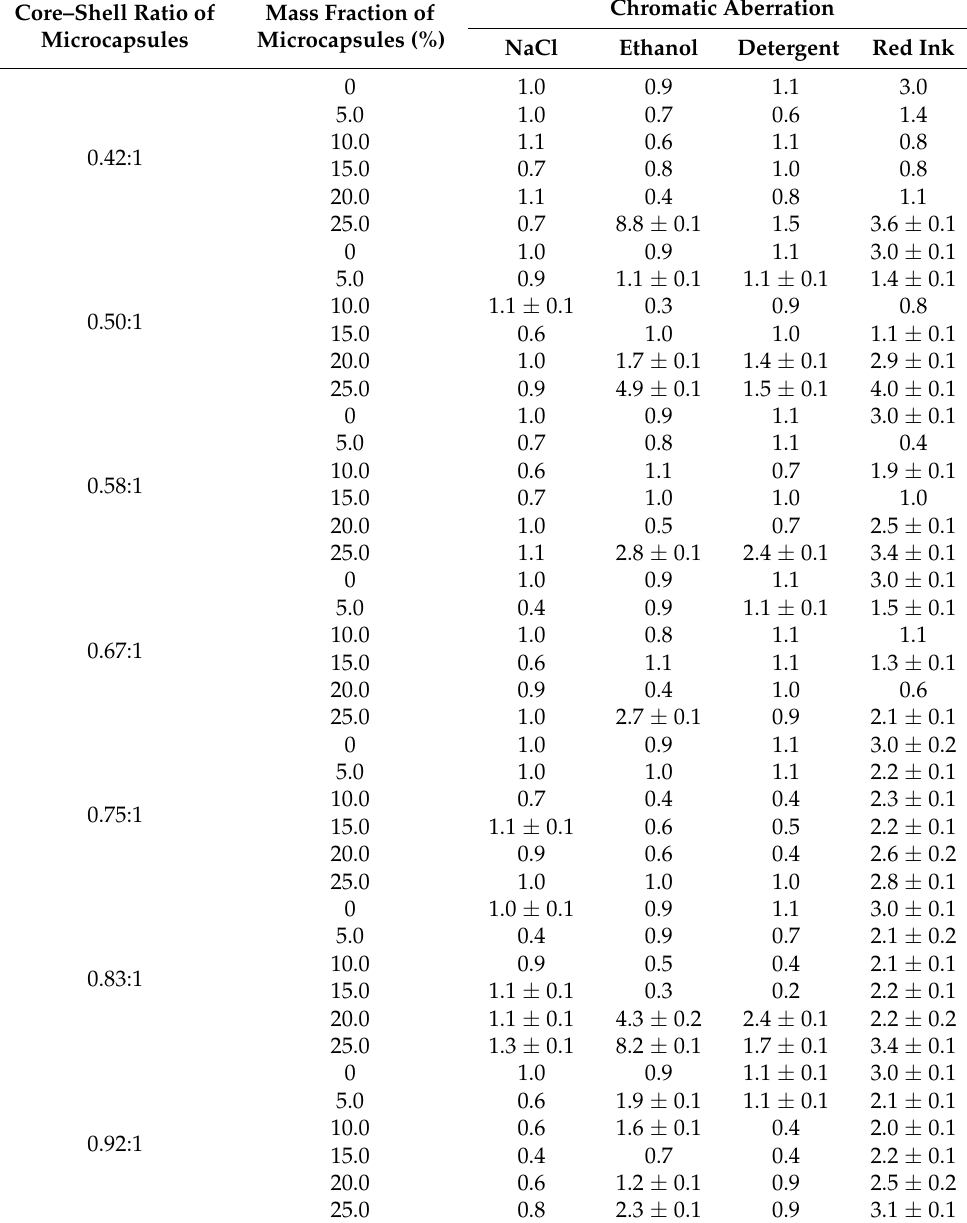
Table 7. Chromatic aberration of the waterborne primer coatings after the resistance to liquid